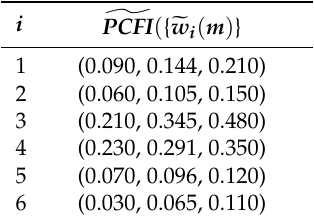
Table 3. Approximating TFNs.